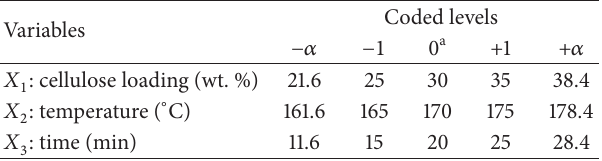
Table 1: Coded levels of variables. Table 2: The arrangement of the central composite